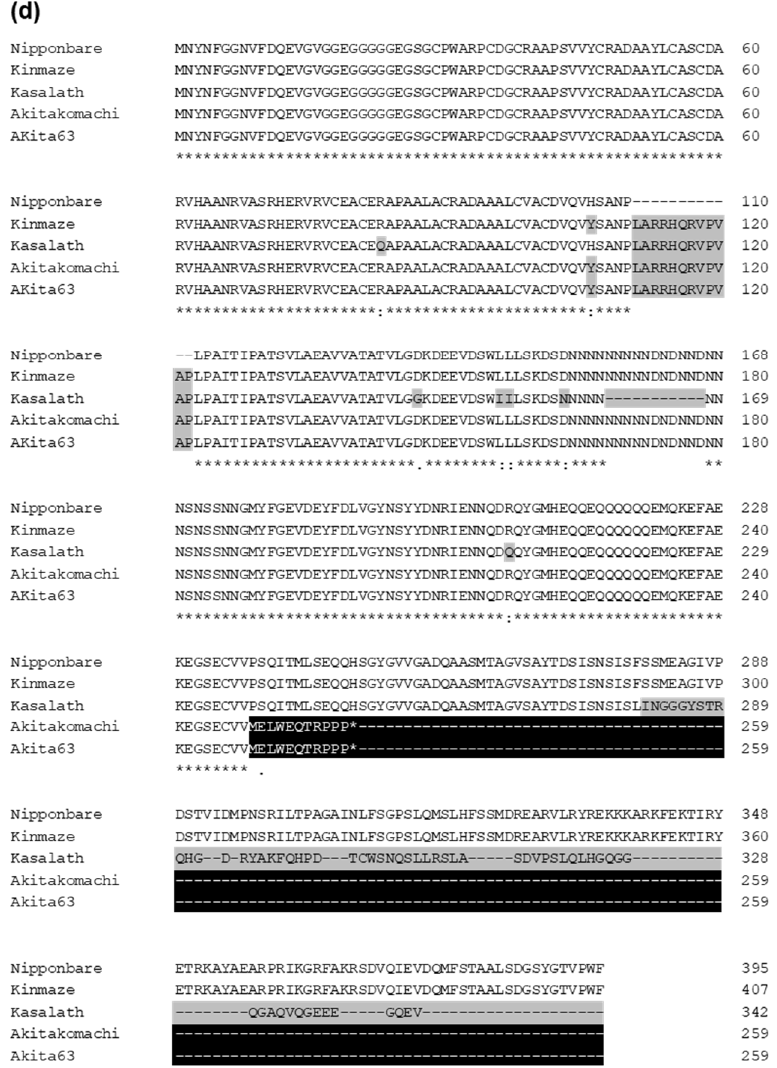
Figure 2. Comparisons of Hd1 DNA sequences and deduced amino acid sequences in various rice lines. ( a ) Schematic representation of the Hd1 gene structure in Akita 63. The positions of SNPs and resulting amino acid substitutions relative to Nipponbare are indicated. Ins, insertion; del, deletion; fs*12, frame shift-generated stop codon after 12 amino acids. The letter ‘g’ followed by a number indicates the nucleotide position in genomic DNA. Similarly, letters ‘c’ and ‘p’ followed by numbers represent the nucleotide position in cDNA and amino acid position in protein, respectively. Numbers in brackets indicate the number of nucleotide or amino acid insertions. ( b , c ) DNA sequence alignments of Hd1 from 1598 to 1764 bp ( b ) and from 2005 to 2117 bp ( c ). The nucleotide positions correspond to the Hd1 sequence of Nipponbare. ( d ) Full-length amino acid sequence alignment of Hd1. DNA and protein sequences different from Nipponbare are indicated with gray boxes, and regions missing in Akita 63 and Akitakomachi are indicated by black boxes. Sequences used to cre-